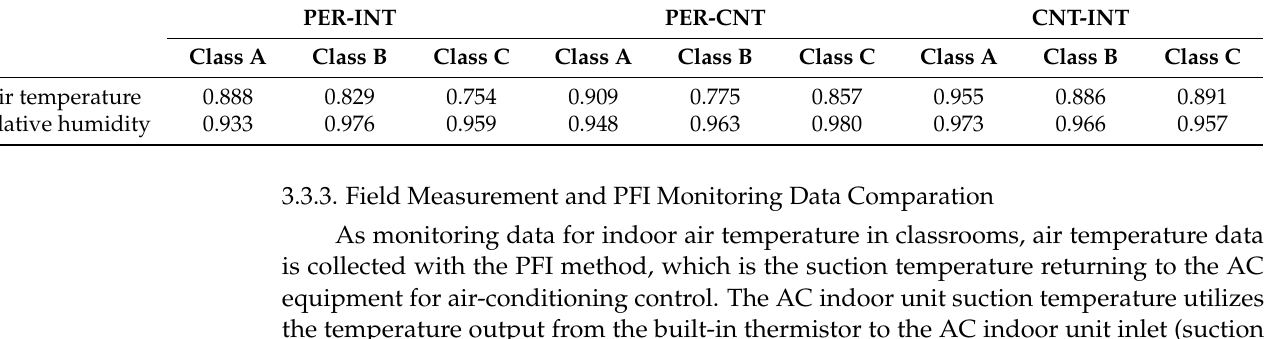
Table 5. Pearson correlation of the PER-CNT-INT